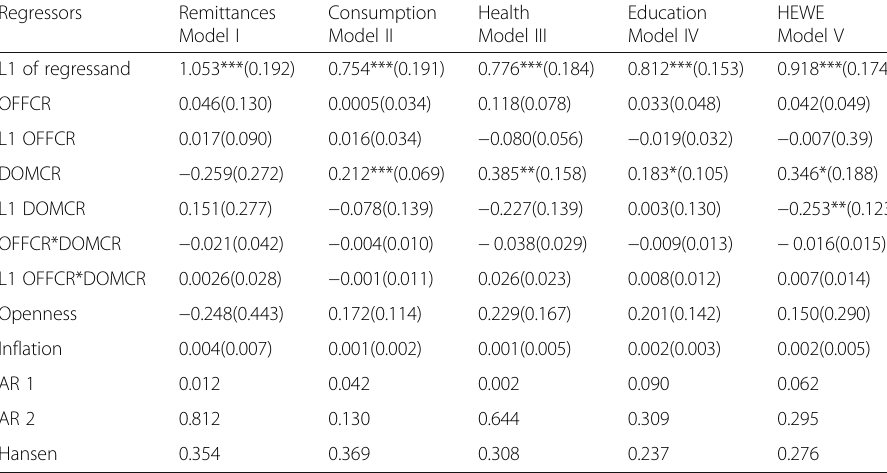
Table 11 Official credit and domestic credit as proxies for foreign capital inflows and financial development